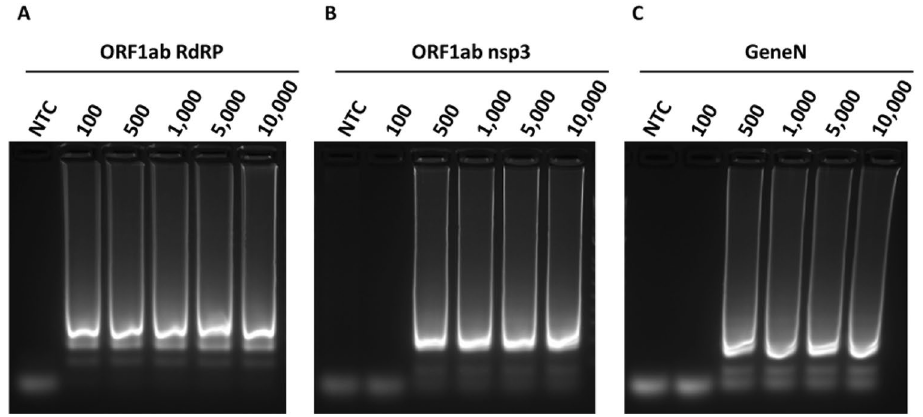
Figure 4. Gel electrophoresis analysis of RT-LAMP assays. Representative gel picture is shown for ( A ) ORF1ab RdRP, ( B ) ORF1ab nsp3 and ( C ) Gene N in RT-LAMP assays, using a dilution series of positive RNA control ranging from 100 copies to 10,000 copies. NTC (no template control) is used as a negative control. n = 3 biological